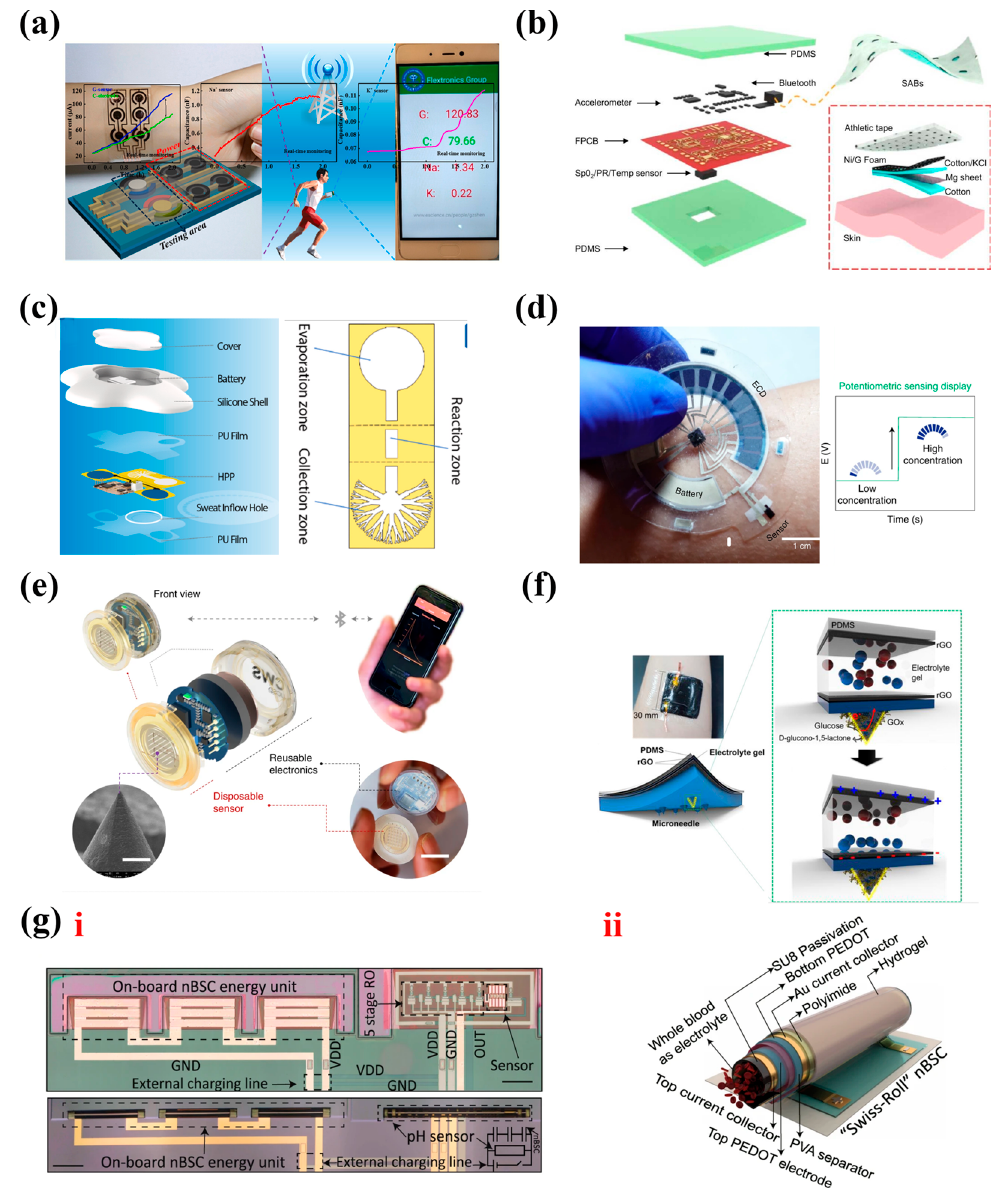
Figure 8. ( a ) Schematic of sensors that detect glucose, [Na + ], and [K + ] in sweat. Reprinted with permission from Ref. [129]. Copyright 2019, Nano Energy. ( b ) Schematic of FSAB-integrated multiple sensing system. Reprinted with permission from Ref. [130]. Copyright 2022, Nano Energy. ( c ) The exploded view of the system for monitoring of electrocardiogram signal and glucose in sweat. Reprinted with permission from Ref. [131]. Copyright 2022, Biosensors and Bioelectronics. ( d ) Schematic of sweat monitoring patch and the readout of potentiometric sensor changing with electrolyte concentration. Reprinted with permission from Ref. [132]. Copyright 2022, Nature Electronics. ( e ) The structure of highly integrated patch. Reprinted with permission from Ref. [136]. Copyright 2022, Nature Biomedical Engineering. ( f ) Schematic of self-charging supercapacitor for glucose sensing and its working principle. Reprinted with permission from Ref. [137]. Copyright 2022, ACS Applied Materials & Interfaces. ( g ) i. Schematic of nBSC; ii. microscope image of pH monitoring system before and after roll-up. Reprinted with permission from Ref. [141]. Copyright 2021, Nature